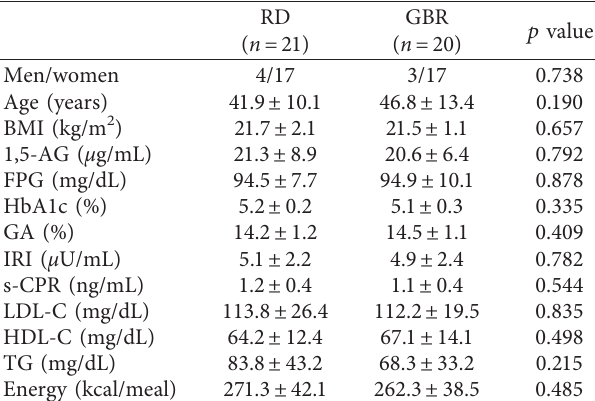
Figure 1: Flow diagram showing the disposition of the subjects. Table 2: Characteristics of the